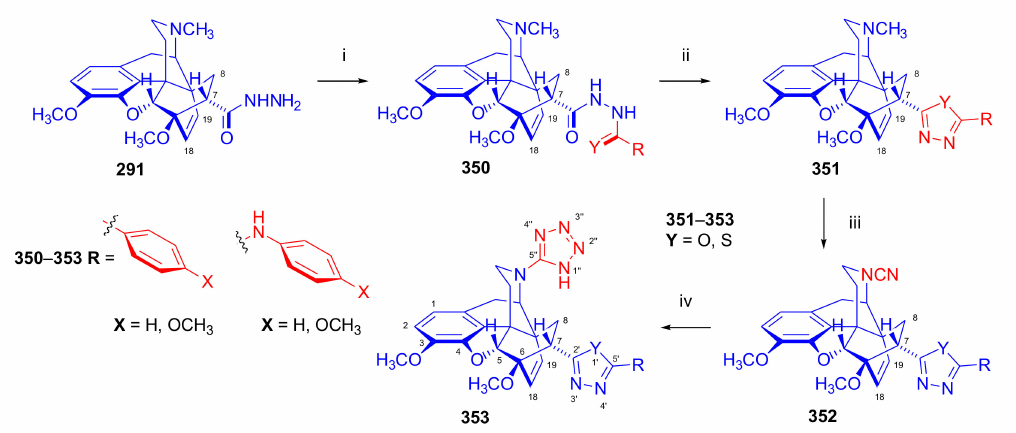
Figure 90. Synthesis of N 17 -(tetrazol-1 H -5-yl)-7 α -substituted (1,3,4-oxadiazol-2-yl) and (1,3,4- thiadiazol-2-yl) 6,14-ethenomorphinan derivatives. Reagents and conditions : (i): (A) benzoyl chloride or p -tolylchloride, or (B) phenylisocyanate or p -tolylisocyanate, or (C) phenyl isothiocyanate or p -tolylisothiocyanate, toluene, 70 ◦ C, 2 h, 78–88%; (ii): POCl 3 or H 3 PO 4 , 72–82% (iii): 2 equiv. BrCN, CHCl 3 , reflux, 24 h, 39–53%; and (iv) NaN 3 , NH 4 Cl, DMF, reflux, 4 h, 69–77%. In 2018, Nagase and Yamamoto [242] described an eight-step transformation of N 17 -cyclopropylmethyl-northebaine ( 9d , Figure 91) into novel type 7-carboxamido-6,14- ethenomorphinan derivatives with a ∆ 7,8 double bond, having a κ OR agonist activity. The 7-keto-6,14-ethenomorphinan intermediate ( 356 ) were prepared applying the method of Lewis et al. [243,244]. In 1971, Lewis et al. [243] described the cycloaddition of 2- chloroacrylonitrile (2.1 equiv.) to thebaine ( 4 ) in boiling benzene. The formation of a 4:1 mixture of the 7 α -cyano-7 β -chloro and 7 α -chloro-7 β -cyano Diels–Alder adducts was observed.